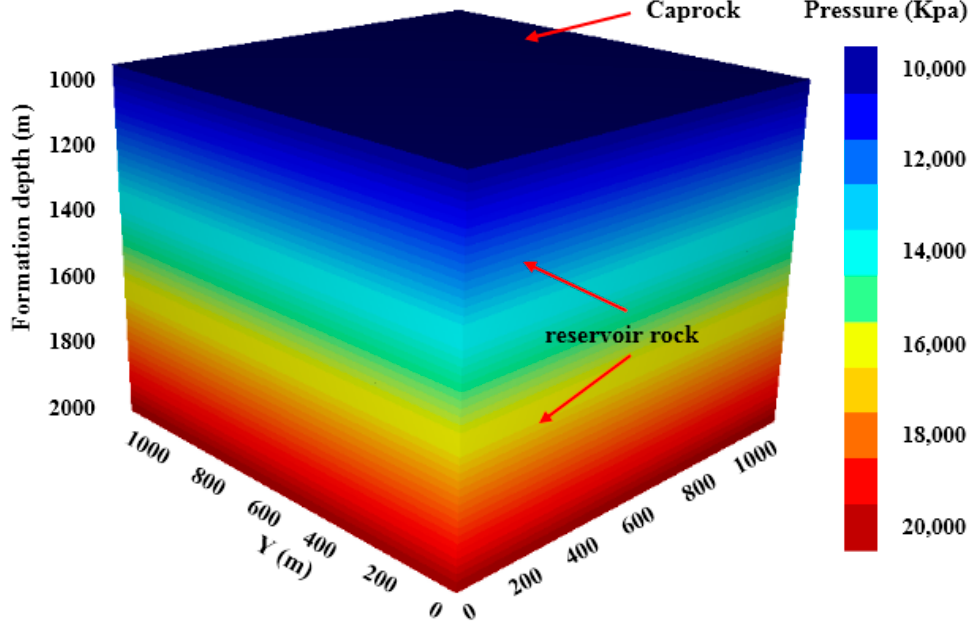
Figure 1. The developed simulation model showing the reservoir pressure distribution.